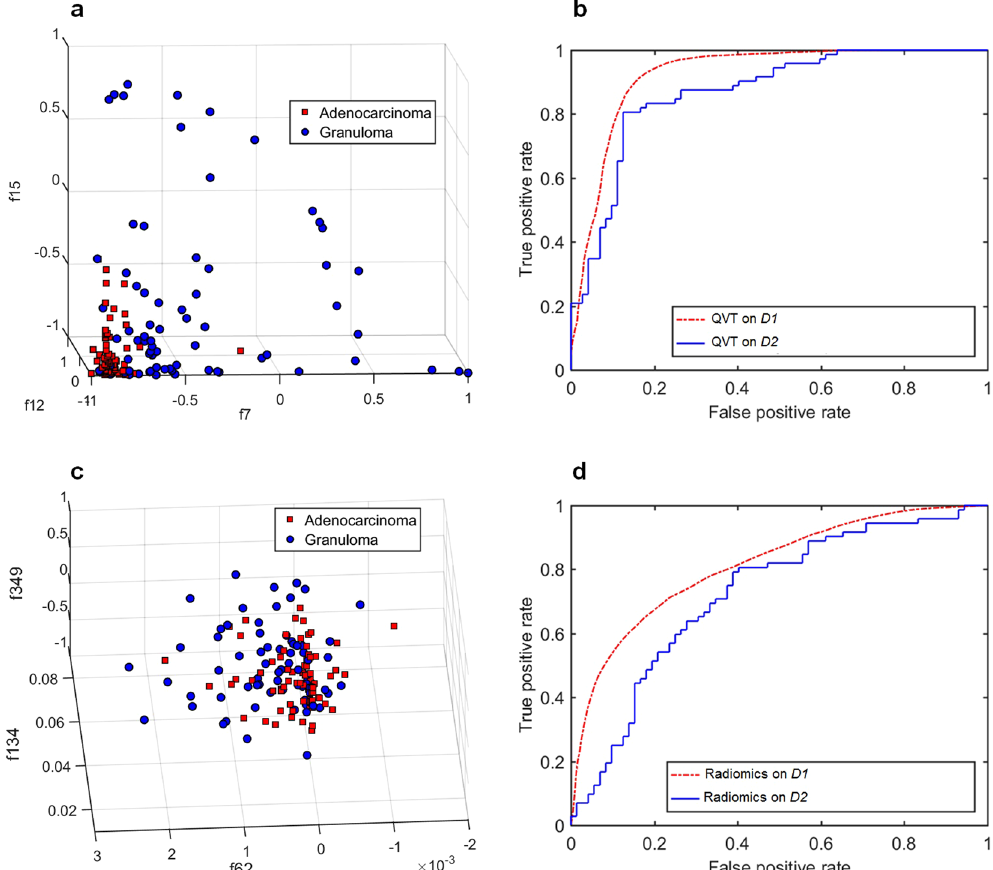
Figure 5. ( a , c ) The 3D cluster plot of adenocarcinomas (red dots) and granulomas (blue dots) within the training set ( D 1 ) in a reduced three dimensional space of the QVT features (top row) and well-known nodules shape and texture radiomic features (bottom row). ( b ) ROC curves of C QVT trained on D 1 and validated on D 2 based off QVT features. ( d ) ROC curves of C rad trained on D 1 and validated on D 2 based off shape and texture radiomic features respectively. C QVT and C rad , respectively, yielded an AUC of 0.85 and 0.73 for cases in D 2 .